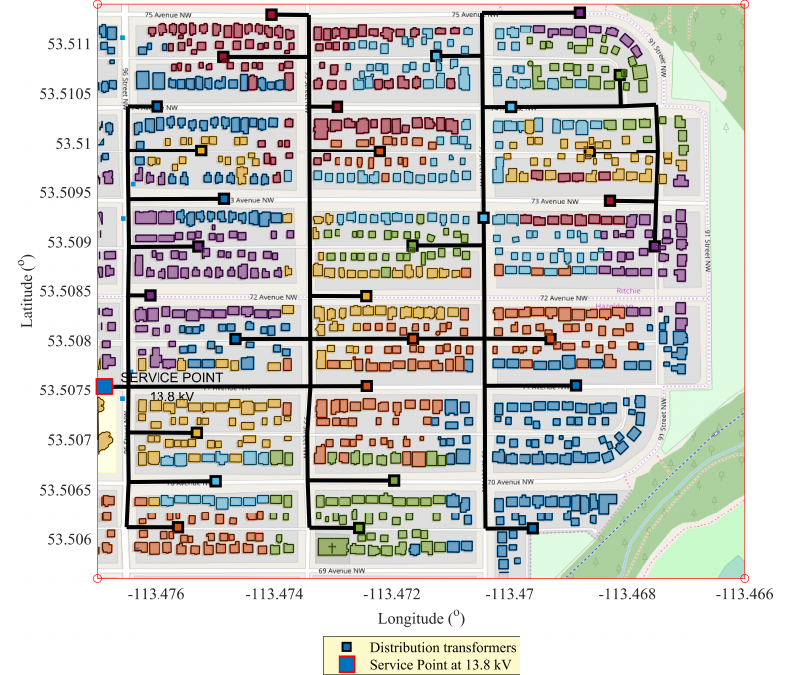
Figure 6. Routing of primary feeder using MST techniques for case study 1.